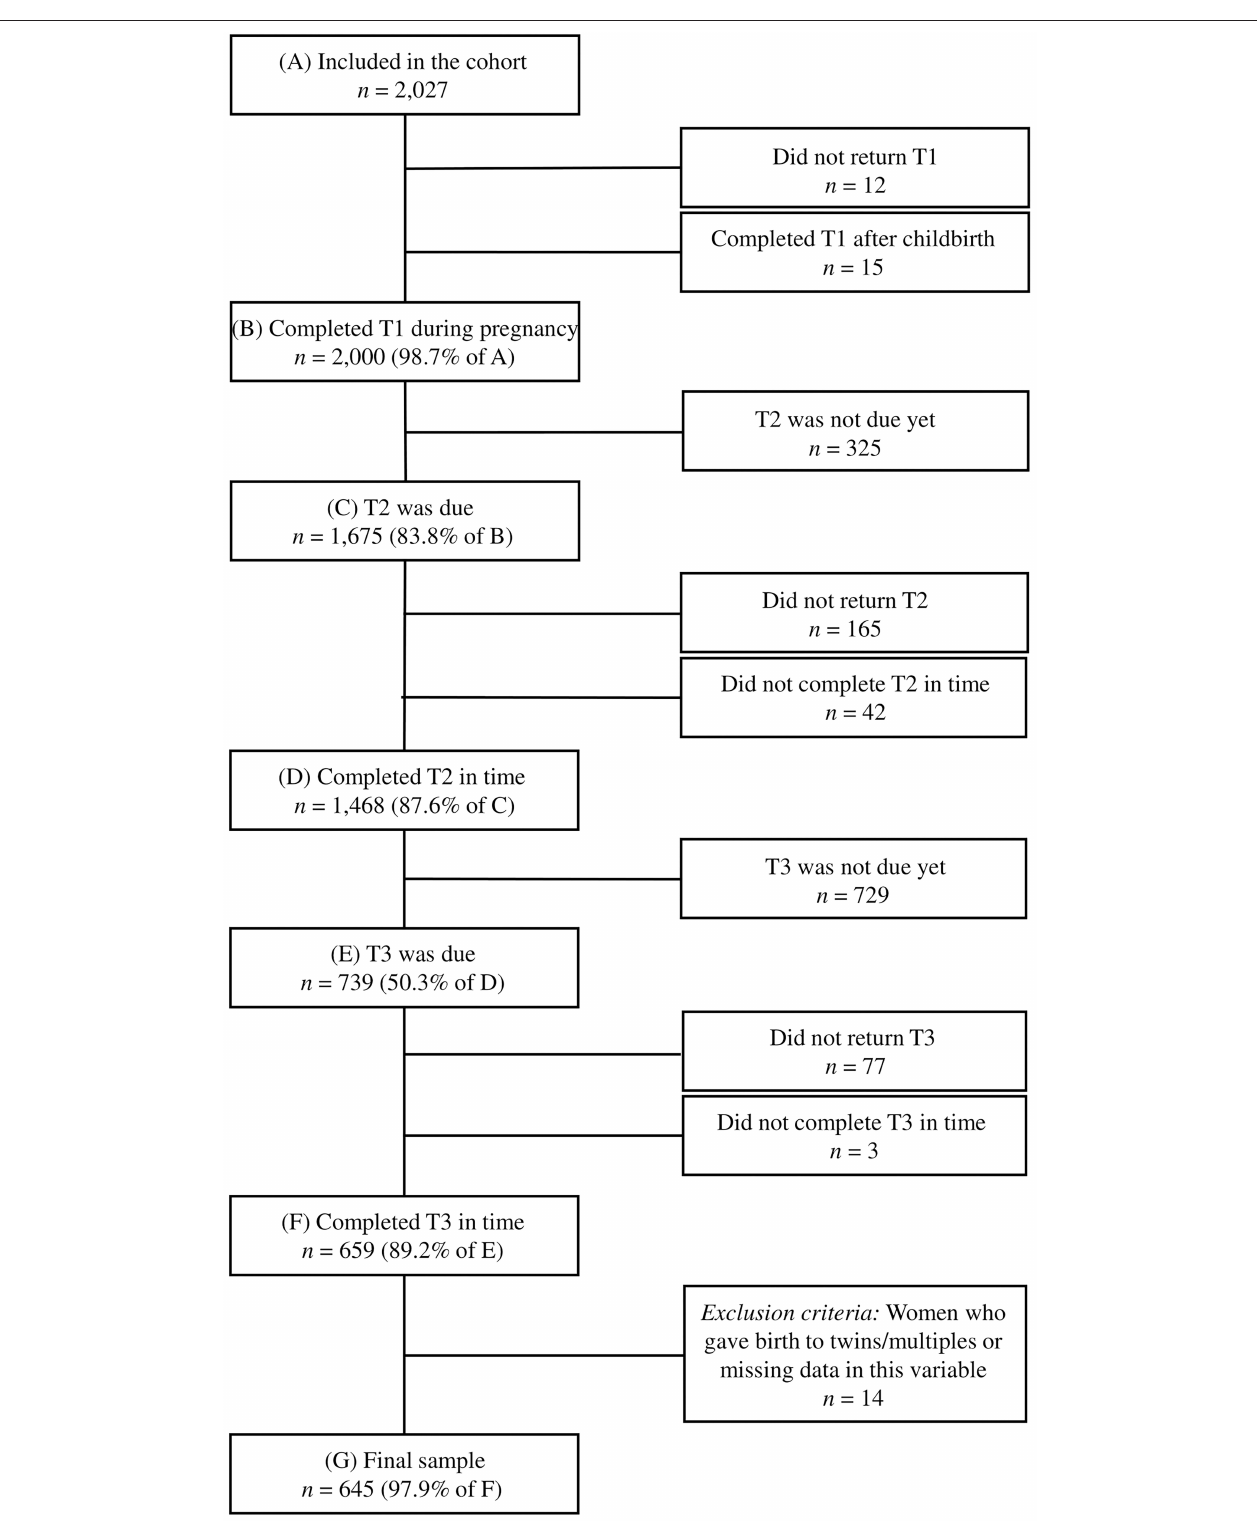
FIGURE 1 | T1, during pregnancy; T2, 8 weeks after the anticipated birth date; T3, 14 months after the birth.